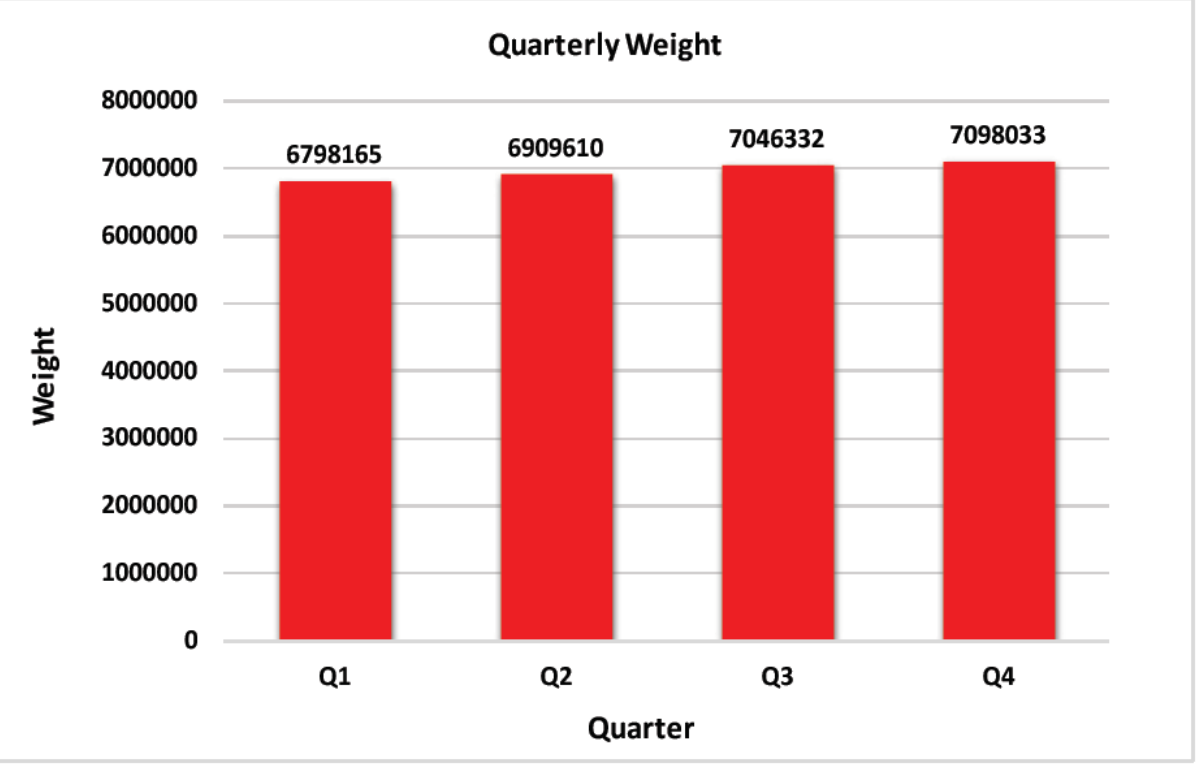
Figure 4. Summary of the Annual, Monthly and Quarterly Weights created to Project the US Population from the a Commercial Patient